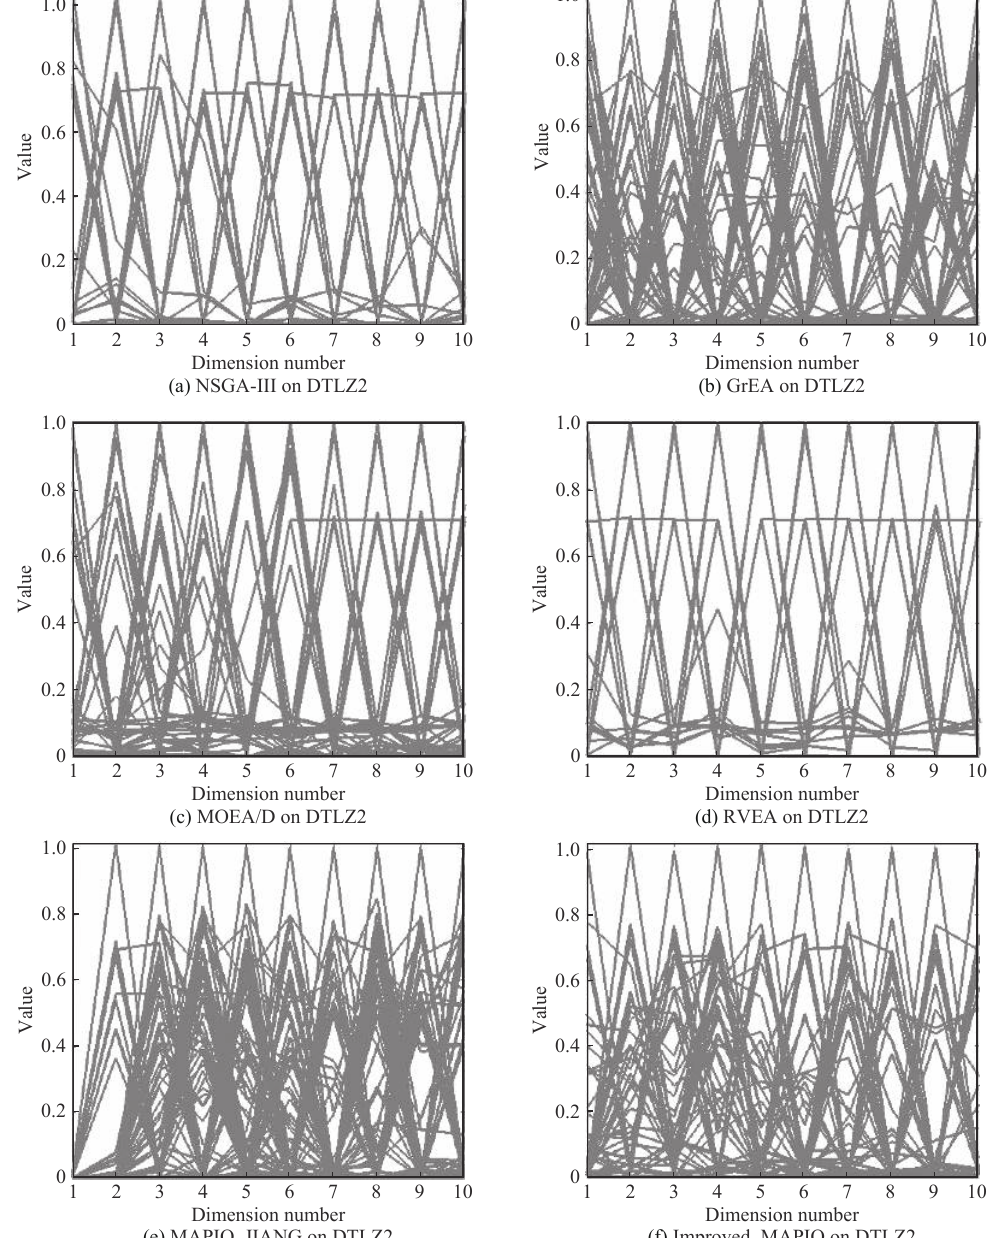
Fig. 3 Pareto front obtained by different algorithms on the 10-objective DTLZ2 test